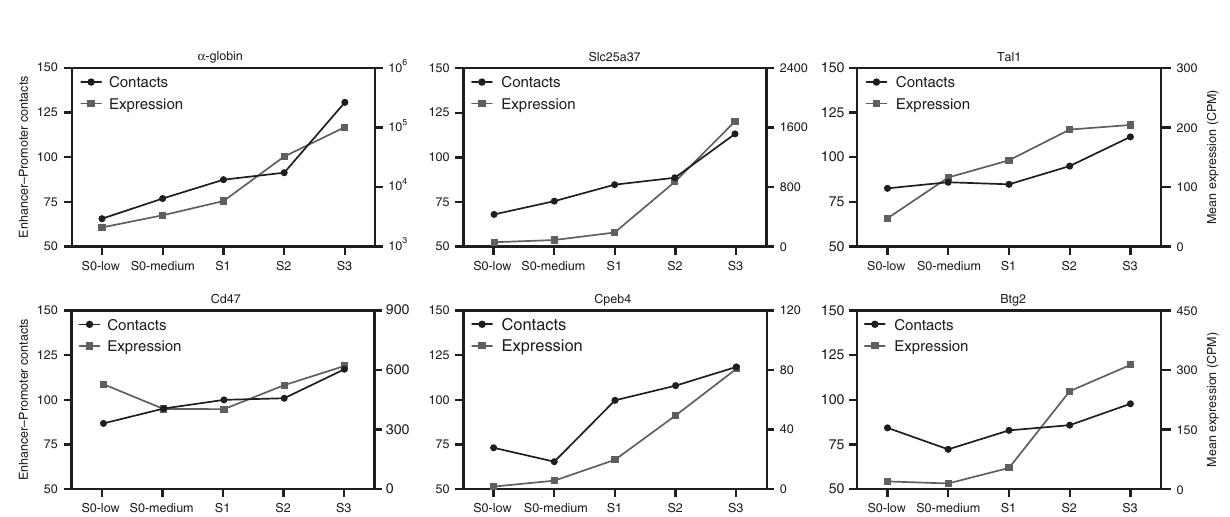
Fig. 4 Upregulation of α -globin expression correlates with increased chromatin accessibility and enhancer-promoter interactions. Tiled-C contact matrices of 500 kb spanning the mouse α -globin locus in sequential stages of in vivo erythroid differentiation at 2 kb resolution. Contact frequencies represent normalized, unique interactions in two replicates. The black and gray bar below each matrix represent the pre-existing TAD (chr11:32,080,000- 32,245,000) and erythroid-speci fi c sub-TAD (chr11:32,136,000-32,202,000), respectively. Matched open chromatin (ATAC) pro fi les are shown underneath the matrices and represent normalized data from 3 S0-low, S0-medium, and S1 replicates and 2 S2 and S3 replicates. The ATAC pro fi les are shown at different scales to highlight changes in accessibility in early stages of differentiation. Gene annotation ( α -globin genes highlighted in red), open chromatin (ATAC; α -globin enhancers highlighted in red), and CTCF occupancy in mature mouse erythroblast cells are shown at the top. Coordinates (mm9): chr11:31,900,000 – 32,400,000.